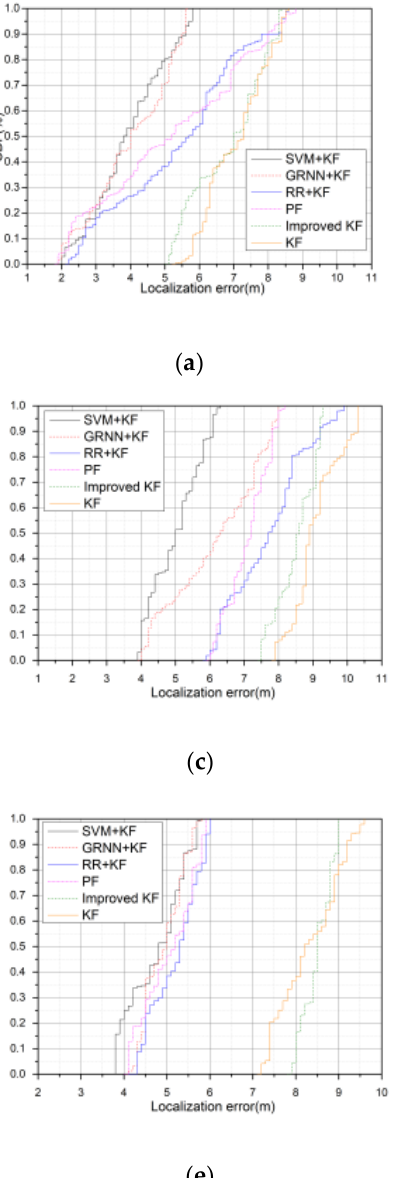
motion model, respectively, and b , d , and f are the simulation results of motion trail 1, 2, and 3 in the